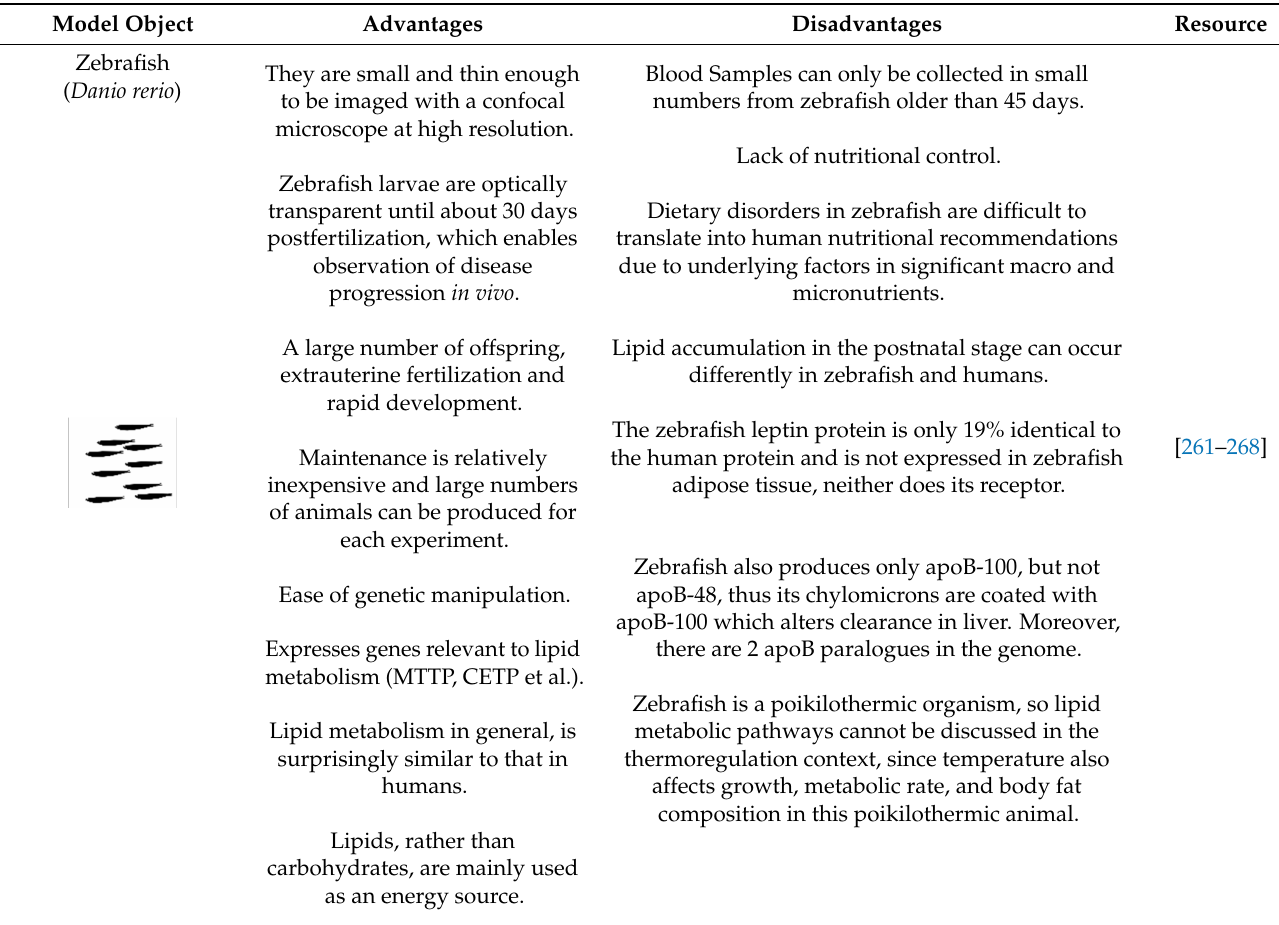
Table 6. Advantages and disadvantages of danio fish used as a model organism for atherosclerosis